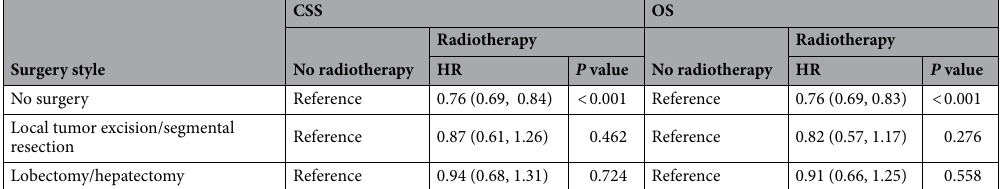
Table 4. Role of radiotherapy related to cancer-specific survival (CSS) and overall survival (OS) in stratified Cox regression analysis. Adjustment factors: Age; Sex; Race; Marital status; Insured status; Year at diagnosis; Grade; Tumor size; AJCC stage;